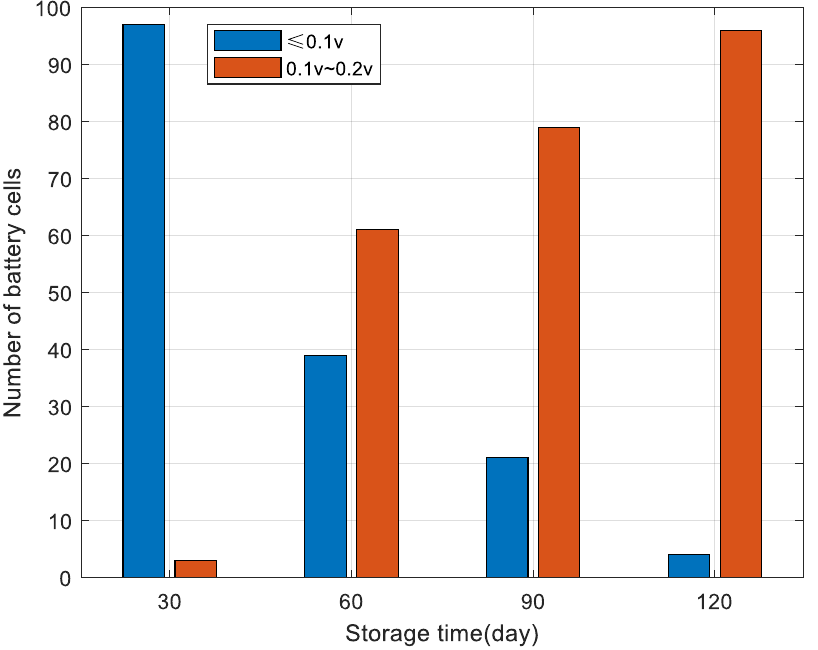
Figure 2. The voltage drop of battery cells in different storage periods.